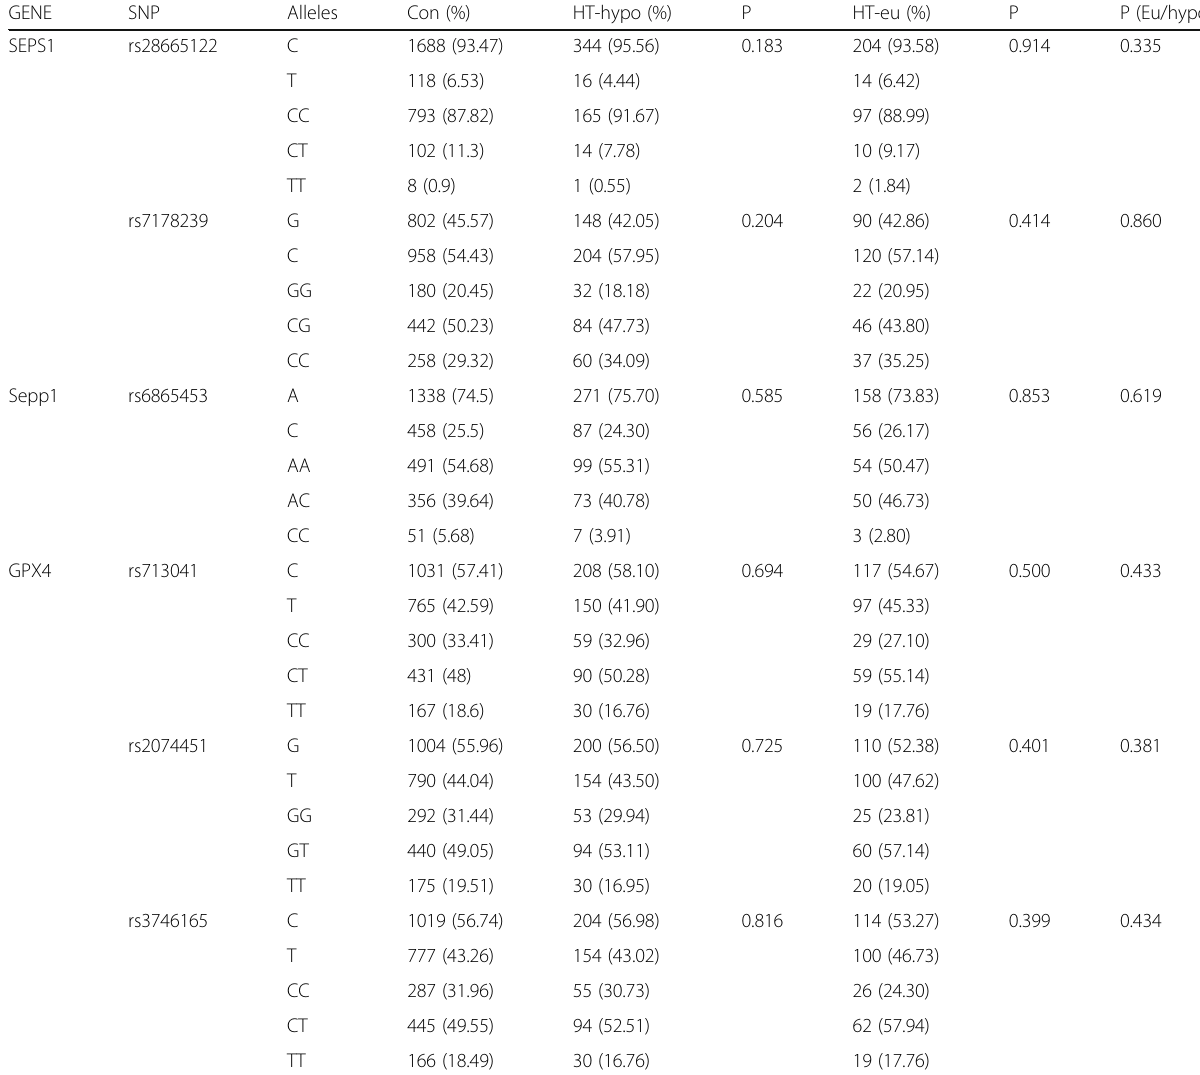
Table 5 Allele and genotype frequencies in HT patients with hypothyroidism or euthyroidism and controls GENE SNP